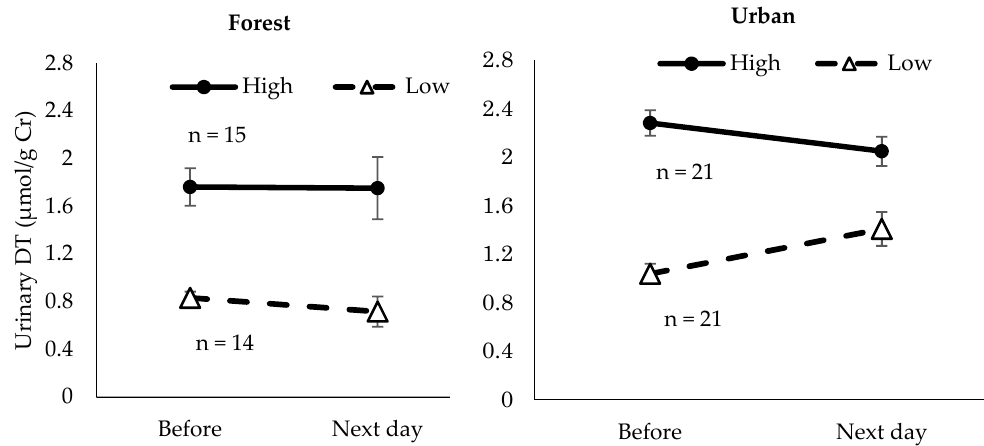
Figure 4. Alteration of urinary DT concentrations in high or low DT group after a forest walk or an urban walk. Data are expressed as mean ± SEM.